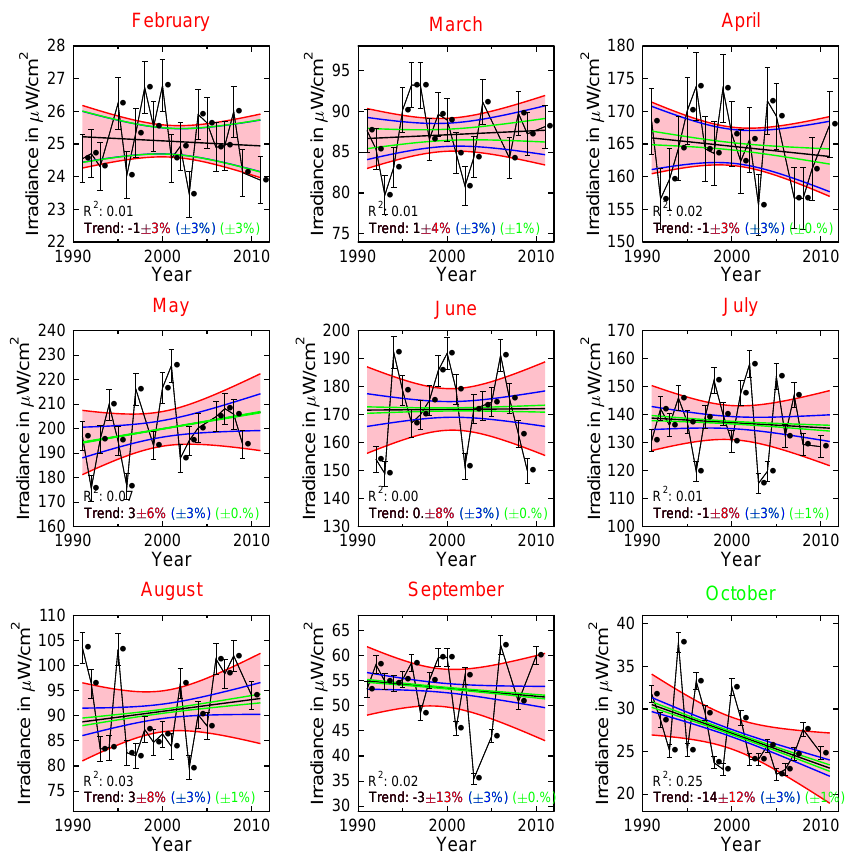
Fig. 2. Time series analysis of irradiance at 345nm. Each panel shows results for a different month, starting with February (top left) and ending with October (bottom right). Black symbols connected by black lines indicate the monthly means ¯ E(y i ) of measured noontime spectral irradiance at 345nm. Data have been corrected for systematic error using Method 4. Error bars indicate the measurement uncertainty u U ( ¯ E(y i )) . Trend estimates are indicated by black lines. Their 95.45% confidence bands are shown in pink shading. The lower half of each plot gives the square of the correlation coefficient ( R 2 ) , the estimate of the decadal trend T (black number), the uncertainty of the trend estimate u(T ) (red number), the uncertainty of the trend that can be explained with the measurement uncertainty u U (T ) (blue number), and the trend uncertainty caused by gaps u G (T ) (green number). The hypothetical confidence bands associated with the measurement uncertainty and the gap uncertainty are indicated by blue and green lines,